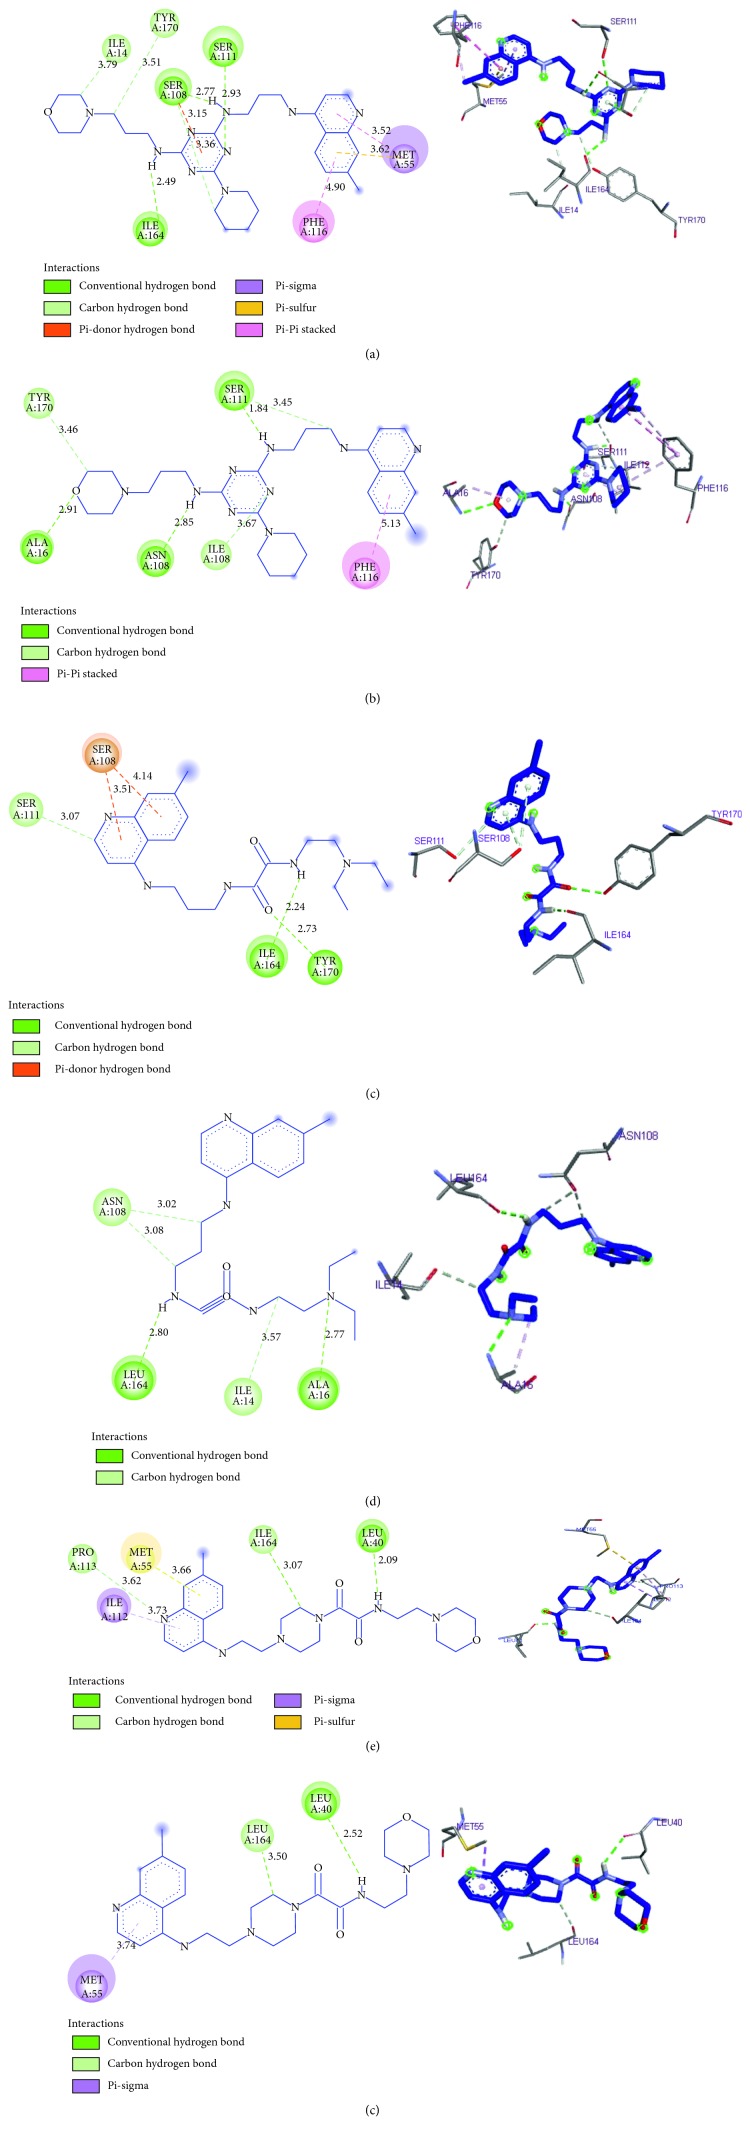
2D and 3D docking poses showing interactions of compounds 9, 26, and 11 in the binding sites of wild type and quadruple mutant of pf-DHFR-TS. (a) Compound 26: wild type of pf-DHFR (binding energy −8.9 kcal/mol). (b) Compound 26: quadruple mutant of pf- DHFR-TS (binding energy −8.3 kcal/mol). (c) Compound 9: wild type of pf-DHFR (binding energy −7.42 kcal/mol). (d) Compound 9: quadruple mutant of pf-DHFR-TS (binding energy −7.96 kcal/mol). (e) Compound 11: wild type of pf-DHFR (binding energy −8.58 kcal/mol). (f) Compound 11: quadruple mutant of pf-DHFR-TS (binding energy −9.2 kcal/mol)